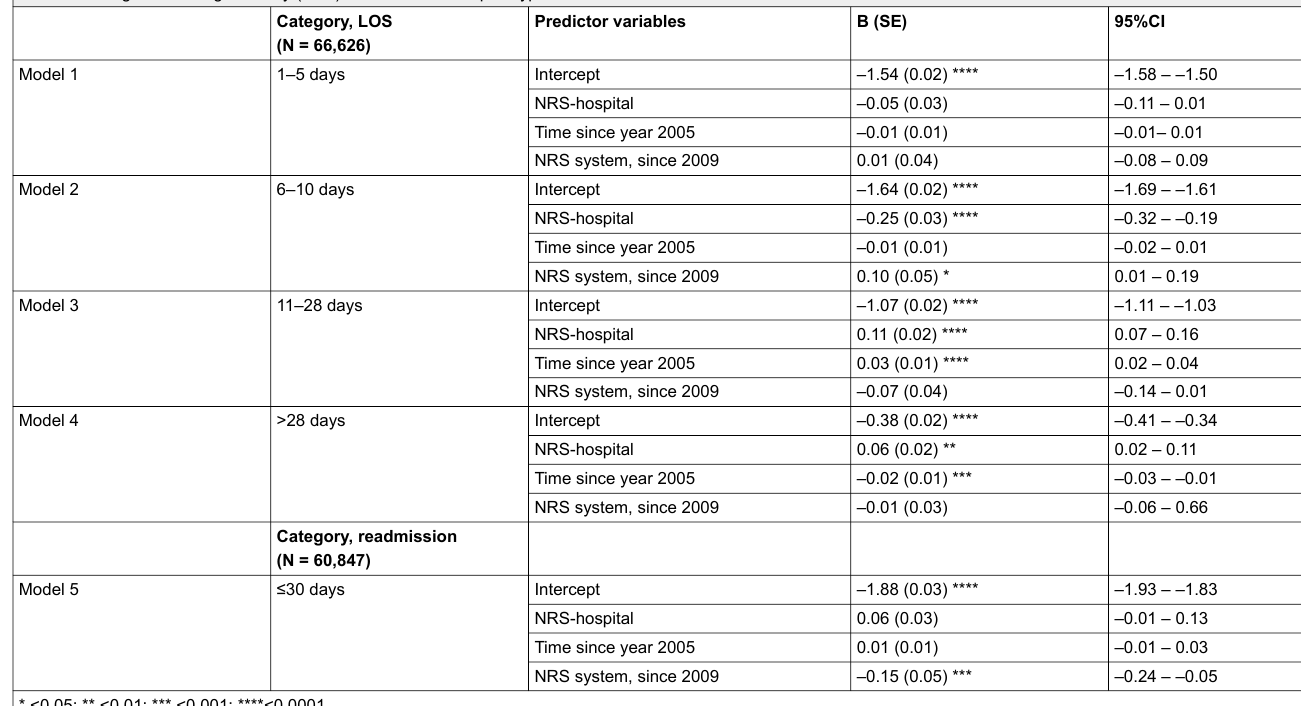
Table 2: Categories of length of stay (LOS) over time and hospital type: GLM. Category, LOS (N =